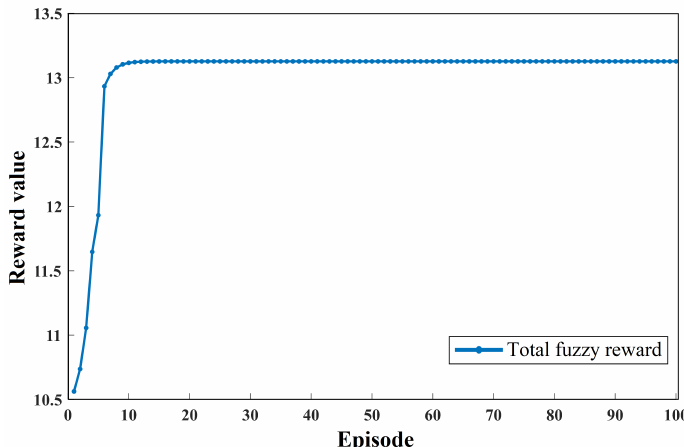
Figure 6. Convergence of the fuzzy reward during the training process of the fusion mechanism.